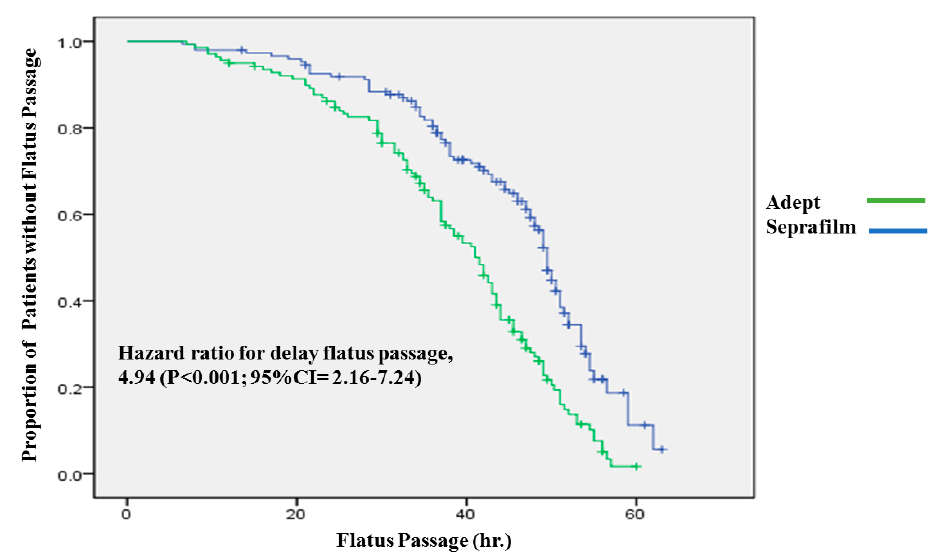
Figure 1. The time of flatus passage (hour). Kaplan–Meier plot of the time of flatus passage, measured from the end of operation to flatus passage. A Cox proportional-hazards model was used to determine the hazard ratio and 95% confidence interval. The Seprafilm group needed longer time (average 4.90 h) for digestive recovery than the Adept group.